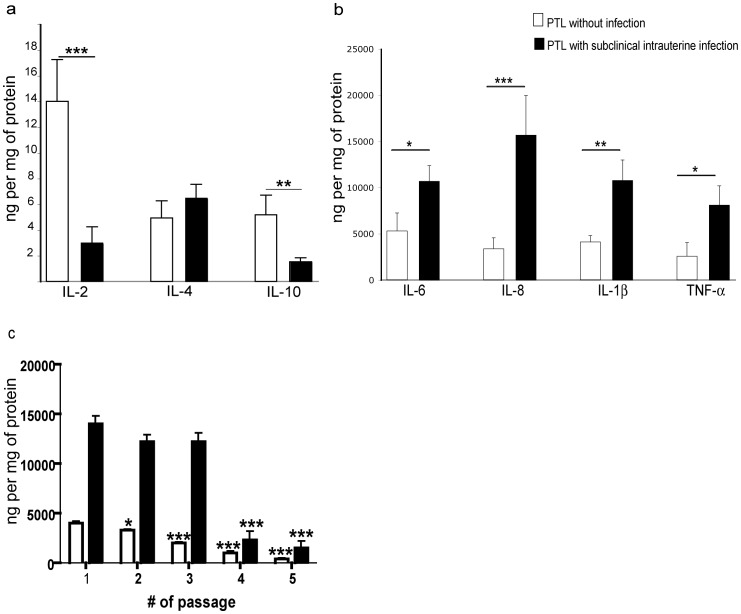
Profiles of cytokines secreted by cultured decidual cells from women with and without subclinical intrauterine infection.Concentrations of: a) anti-inflammatory cytokines, b) pro-inflammatory cytokines, and c) IL-8 in the supernatants of decidual cell cultures from women with preterm labor (PTL), with (n = 10) or without subclinical intrauterine infection (n = 25). Data in c) represent concentrations of IL-8 in the supernatants of progressive culture passages. Data are presented as mean ± SD; experiments were performed in duplicate. ***P<0.001, **P<0.005, *P<0.05 as compared to passage 1 for each group.